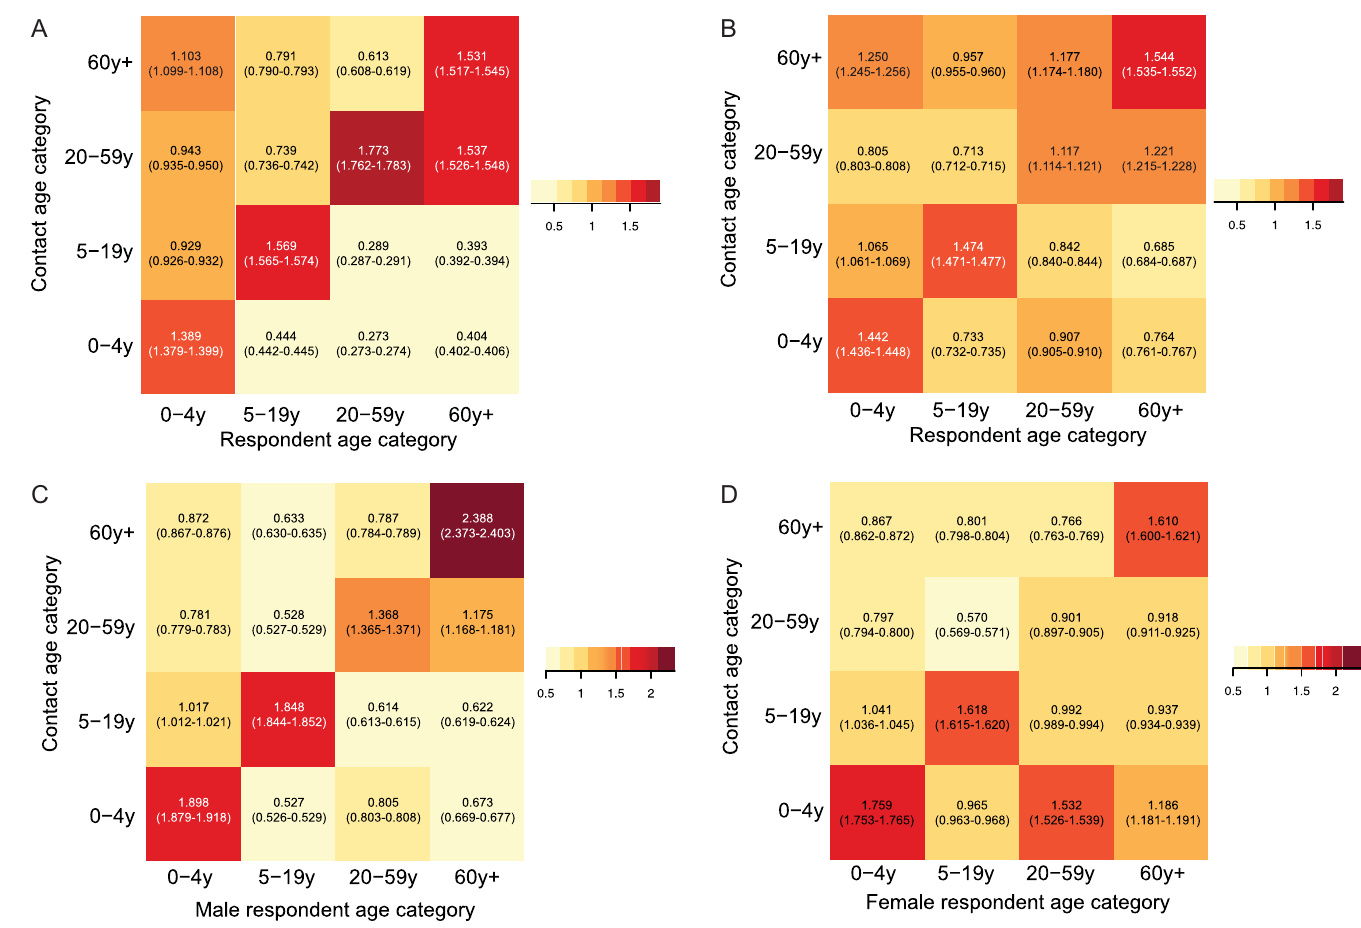
Fig 5. Age-specific mixing matrices for the number (A & B) and duration (C & D) of contacts reported by male (A & C) and female (B & D) respondents. Numeric values represent the ratio of the observed (O) proportion of contacts reported by each respondent age-category with each contact age category to that expected (E) if mixing were proportional to census population proportions in each age category (95%